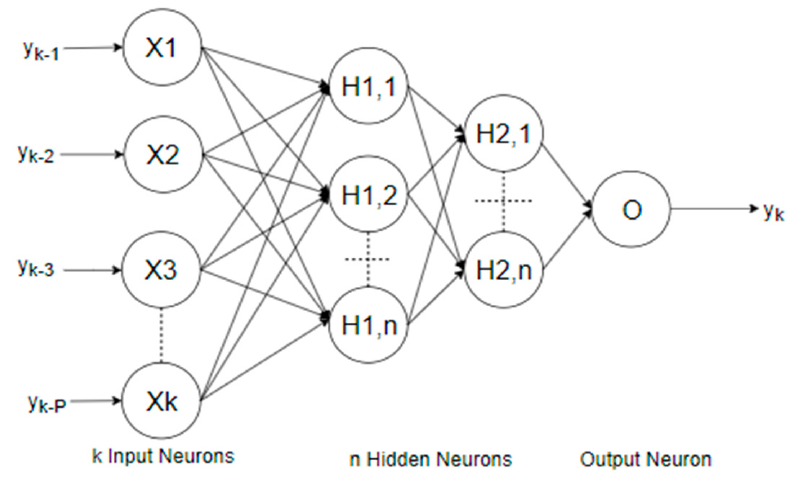
Figure 1. Architecture of a deep neural network (DNN) for runoff prediction.